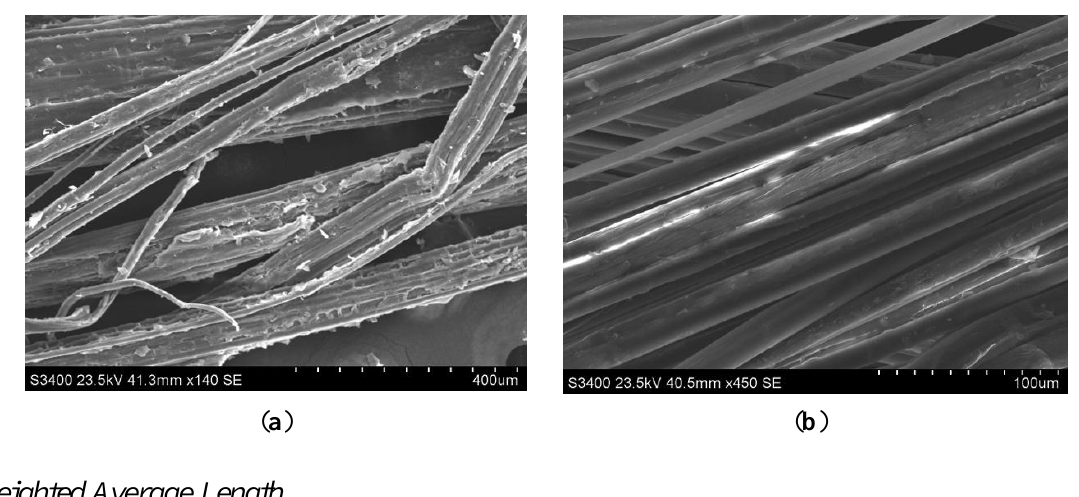
Figure 4. Longitudinal SEM view of ( a ) non-retted and ( b ) retted